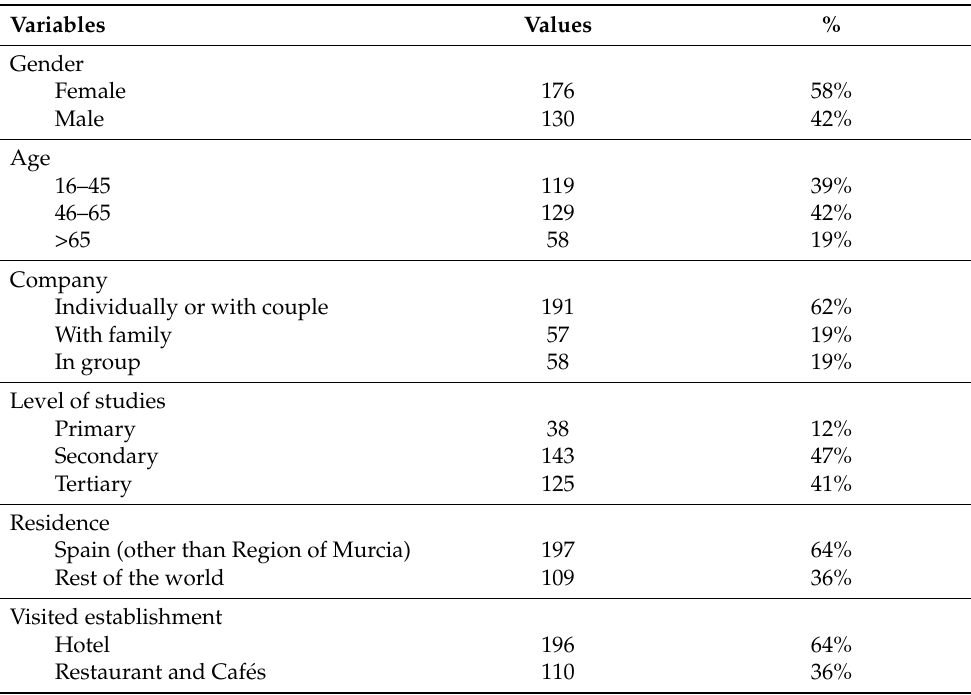
Table 1. Sociodemographic characteristics of the